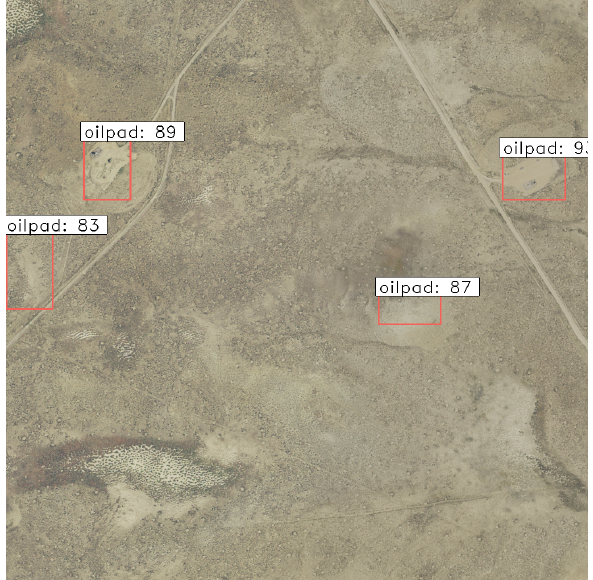
Figure 4. Model prediction on validation image from multiple oil pad set with 2 oil pads and naturally found cleared area.